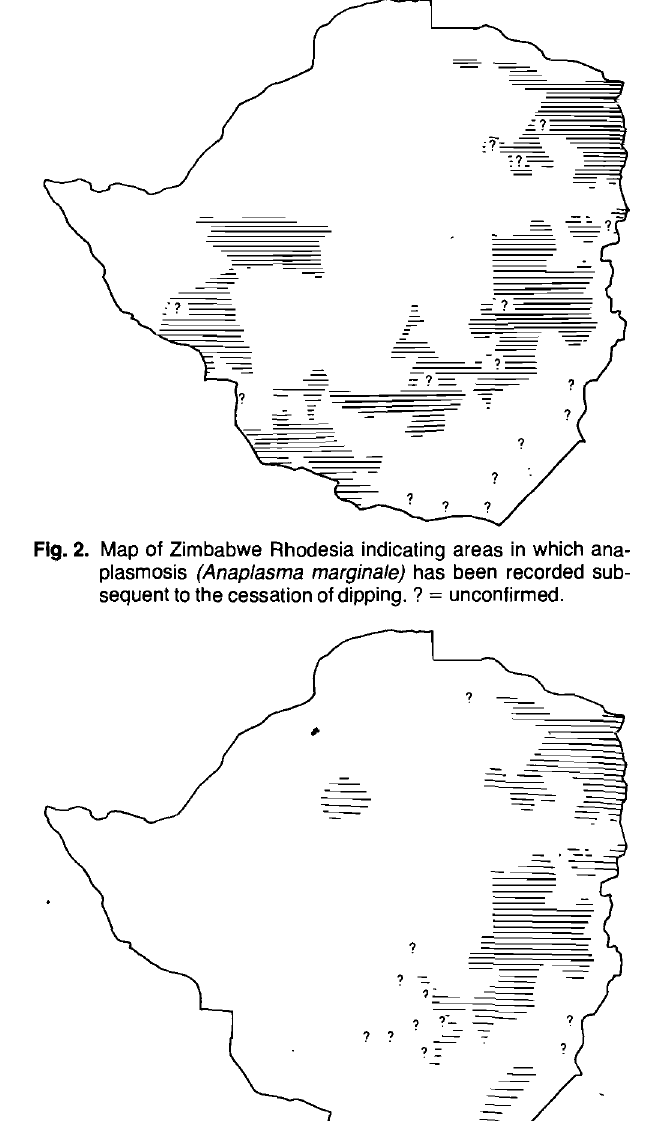
Fig. 3. Map of Zimbabwe Rhodesia indicating areas in which redwa ter (Babesia bigeminal has been recorded subsequent to the cessation of dipping. ? = unconfirmed.